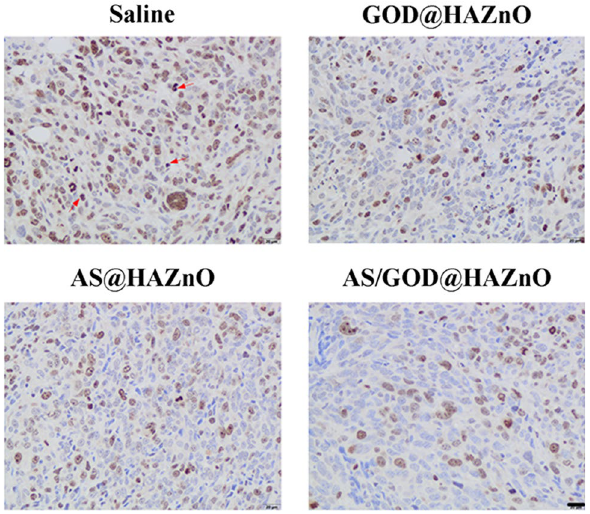
Figure 10. The IHC analysis result of tumor tissues from mice treated with saline, GOD@HAZnO, AS@ HAZnO, and AS/GOD@HAZnO NPs. Scale bar = 20 μm.